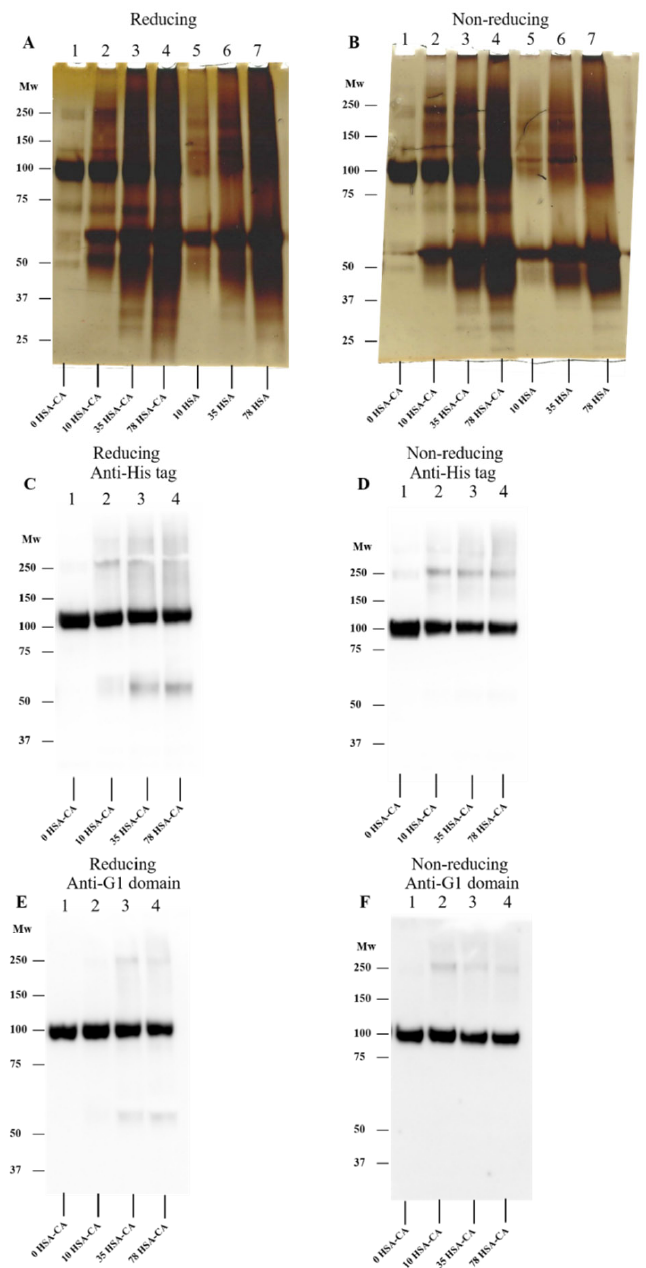
Figure 8. Effects of HSA chloramines (HSA-CA) on rhAggrecan. Defined molar excesses of HSA-CA were incubated with rhAggrecan (643 nM) for 24 h at 37 ◦ C in buffer A. Control samples containing PBS-treated HSA at identical HSA concentrations were also run (bars labelled 10 HSA-control, etc.) before analysis by SDS-PAGE with silver staining ( A , B ) or Western blotting by using the anti-His antibody ( C , D ), or the anti-G1 domain antibody ( E , F ), with the gels run under reducing condition ( A , C , E ) or nonreducing condition ( B , D , F ). For further details see Section 2 and the legend to Figure 3. The position of molecular mass markers is indicated on the left of each image. Representative images are presented from three independent